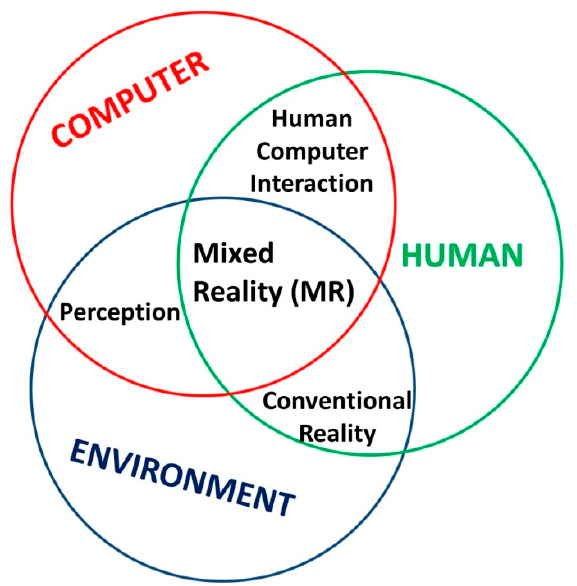
Figure 5. Human–Computer–Environment interaction for MR creation. Produced by authors adapting source [8].